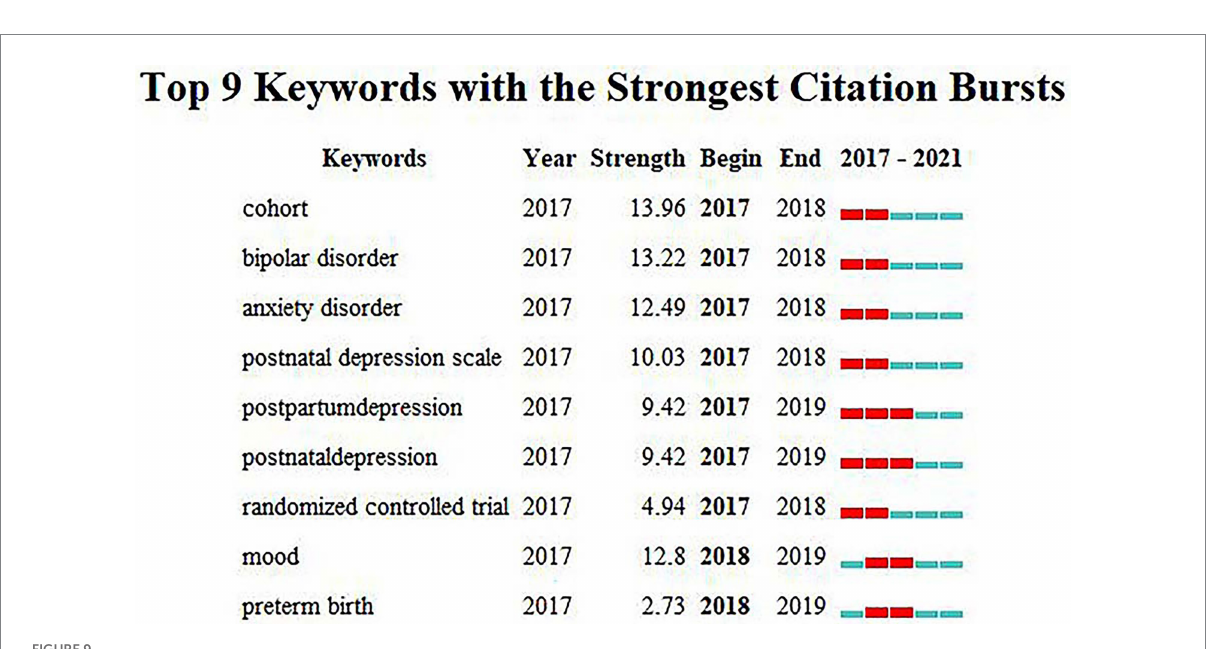
FIGURE 9 Top 9 Keywords with the Strongest Citation